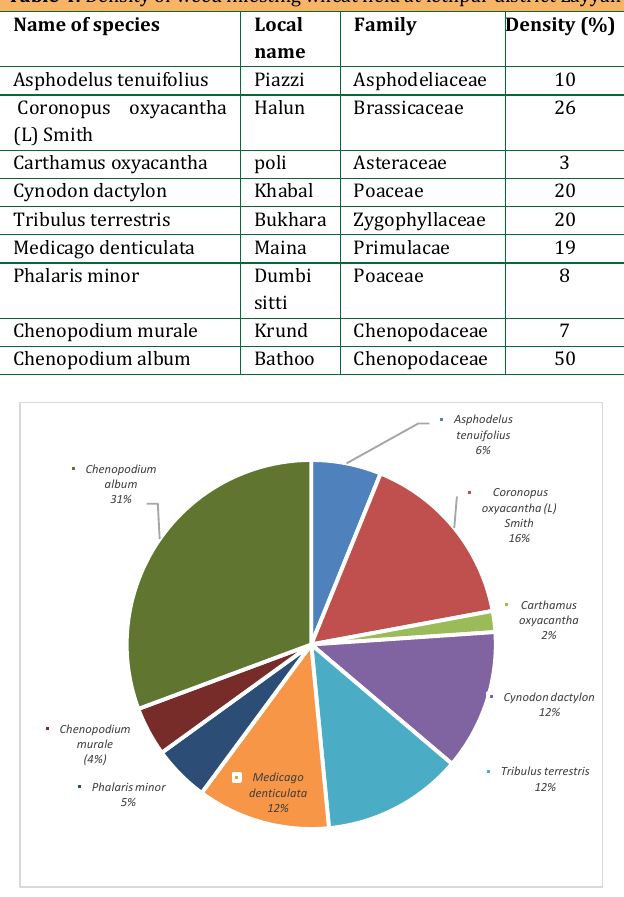
Figure 3: Frequency of weed infesting in wheat field of Fethpur District Layyah. Table 4: Density of weed infesting wheat field at fethpur district Layyah